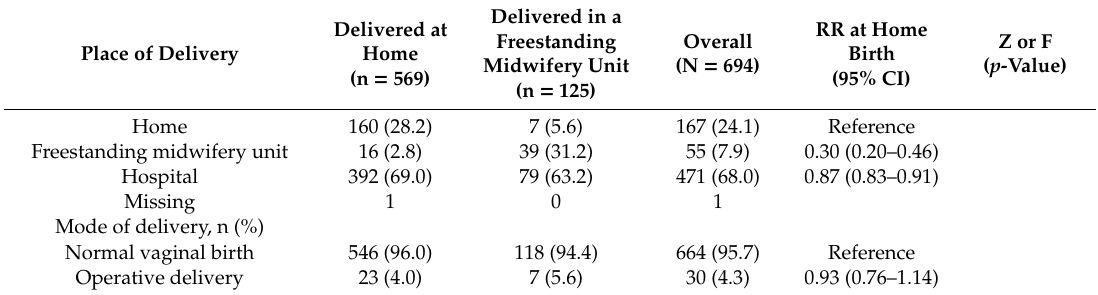
Table 2. Data on prior pregnancies [n, (%)], by birth at home or in a midwifery